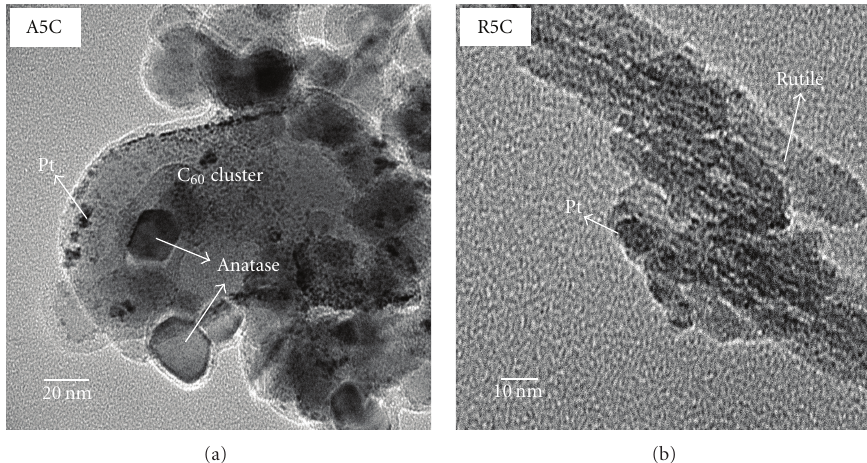
Figure 9: TEM images of the A5C and R5C samples after the photodeposition of Pt